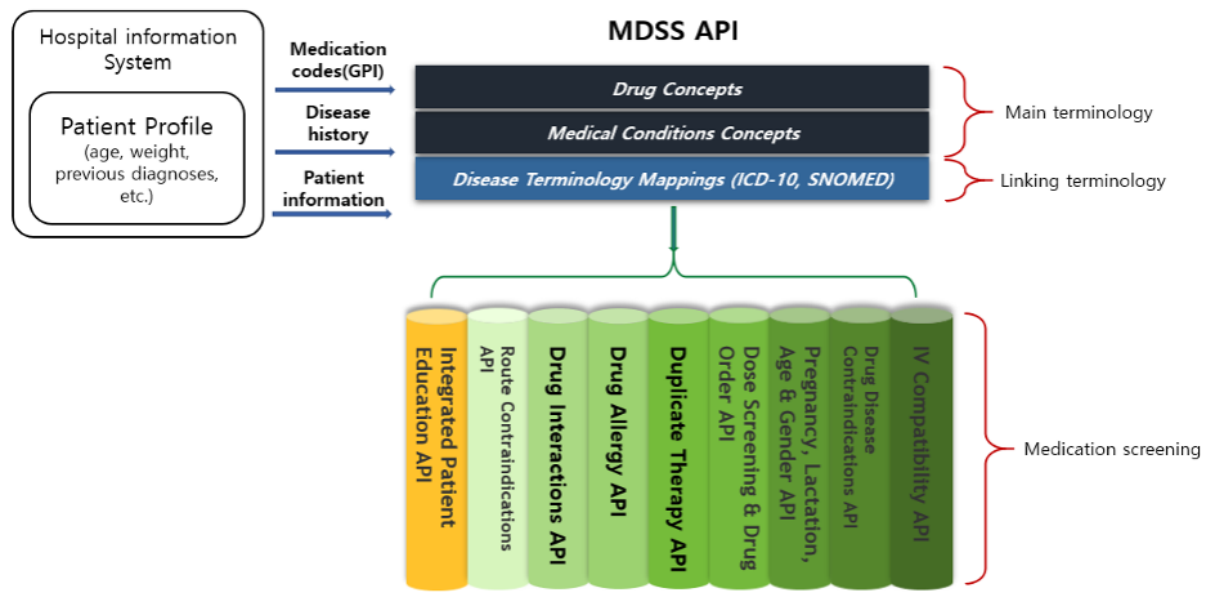
Figure 2. MDSS function list. API: application programming interface; GPI: generic product identifier.